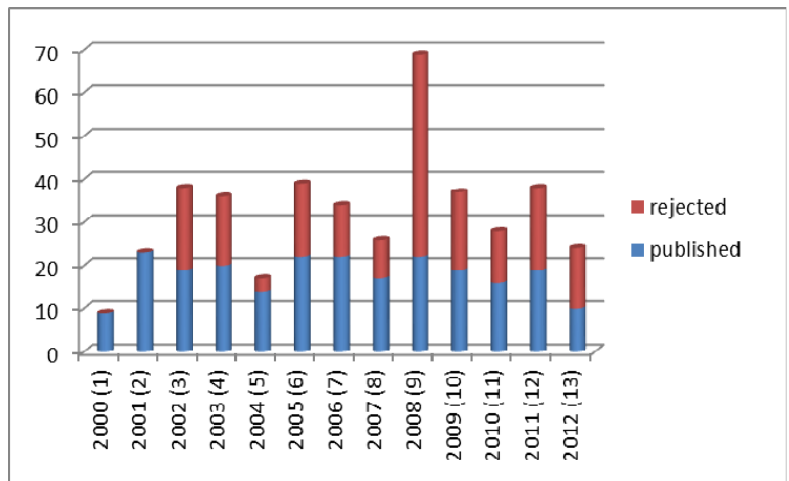
Fig. 1.Amount of published and rejected papers in 2000-2012